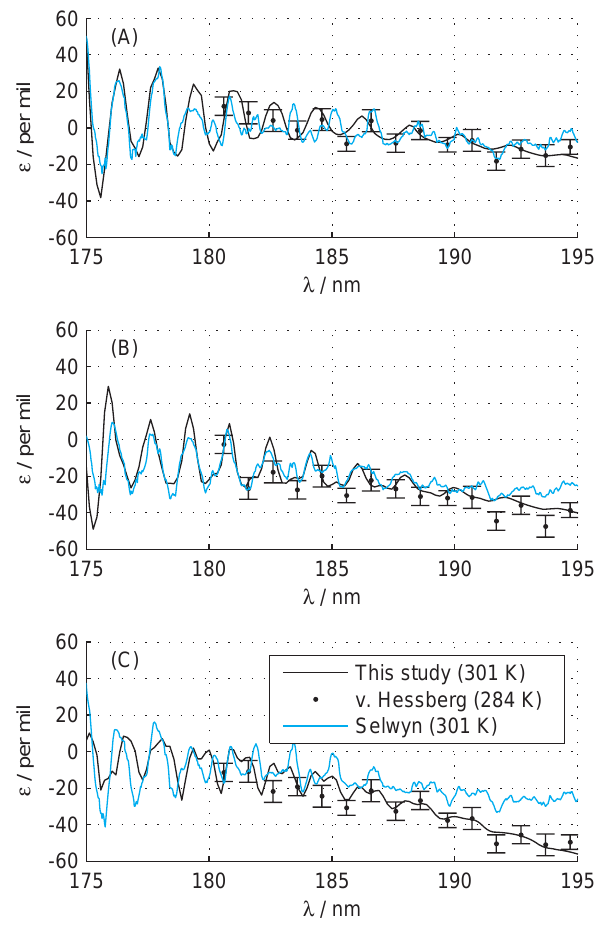
Fig. 4. The fractionation constants for 15 N 14 N 16 O (Panel A ), 14 N 15 N 16 O (Panel B ), 15 N 216 O (Panel C) compared to experimen- tal results of von Hessberg et al. (2004), and Selwyn and Johnston (1981). The legend in Panel C applies to all panels. A blue shift of 300cm − 1 (about 1nm) has been applied to our results in all panels of this